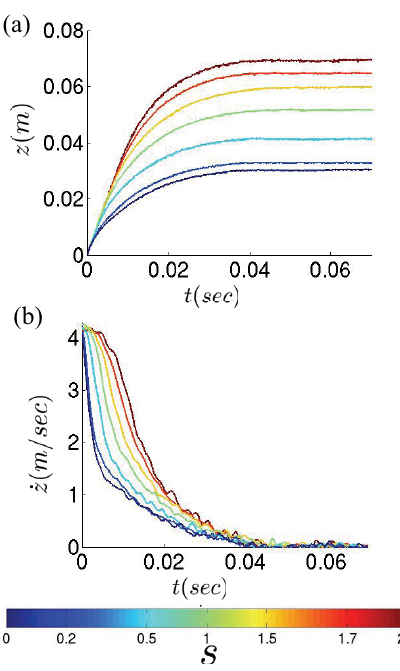
Figure 2. (a) z vs. t , varying s , all impacting sand from the same release height. The maximum penetration depth increases with increasing s . (b) ˙ z vs. t . The decline of ˙ z ( t ) changes with increasing s , but all curves reach ˙ z = 0 at approximately the same time. Data sets correspond to s values given by the